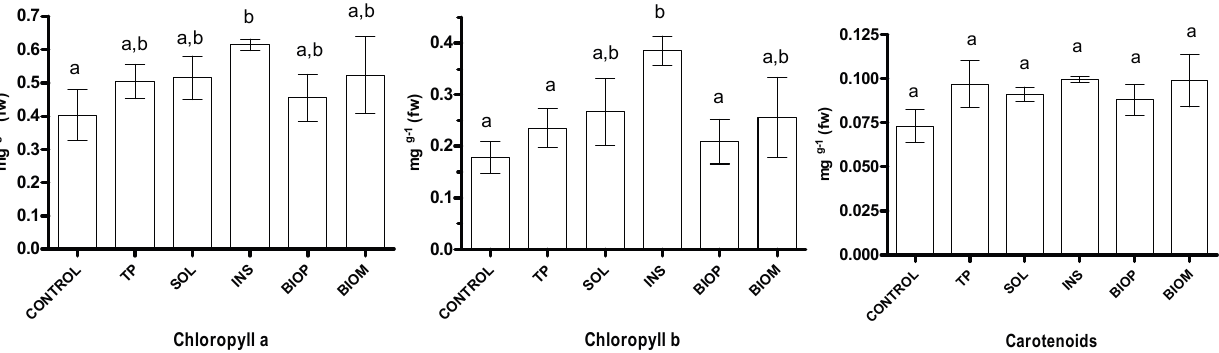
Figure 5. Plant pigment content. Values are the mean of three replications with standard deviation. Letters in columns indicate statistical significance—samples not sharing a letter differ significantly at p <